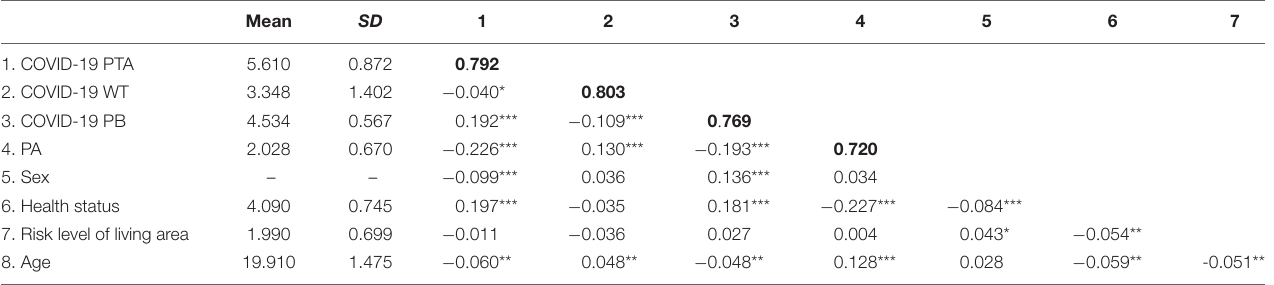
TABLE 3 | Mean, SD, correlation coefficients, and square root of average variance extracted values.